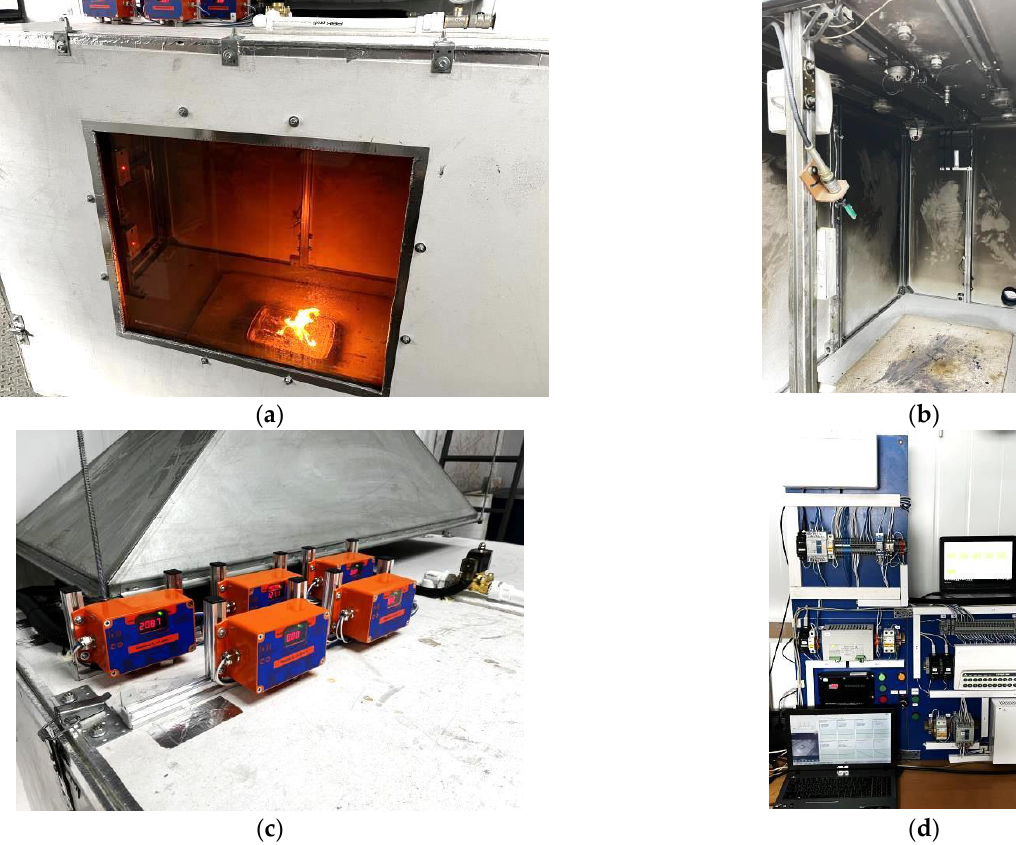
Figure 2. Appearance: ( a ) of the setup exterior; ( b ) of the inner part of the setup; ( c ) of the gas analysis system; ( d ) of the control panel for data collection and fire suppression control.